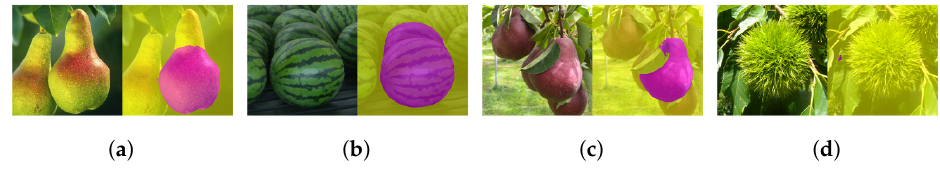
Figure 8. Unsuccessful examples. ( a ) The central fruit is not round enough. ( b ) Two boundaries were mixed up. ( c ) The central object is disrupted by the leaf. ( d ) The boundary is spiky. The original photo of ( a ) is credited to USDA ARS (Keith Weller). The original photos of ( b – d ) are credited to Hideki Murayama.